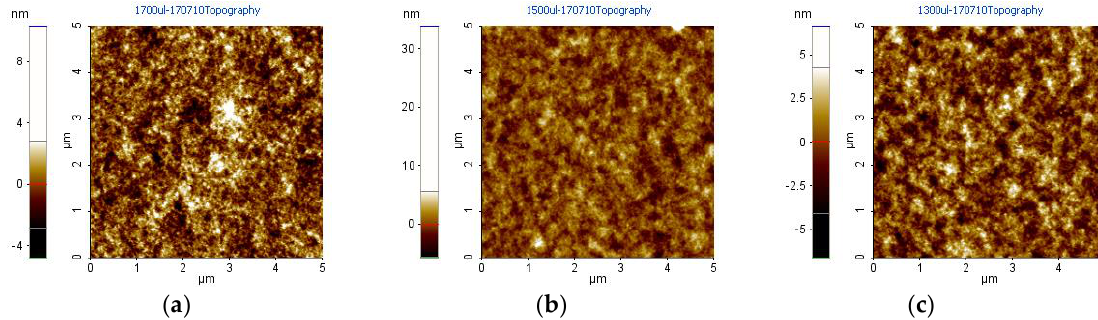
Figure 3. The surface roughness and grain size of improved PEDOT:PSS with three extractions of ( a ) 1700, ( b ) 1500, and ( c ) 1300 µ L from an atomic force microscope (AFM) measurement. Table 2. The surface roughness (Rq) values about improved PEDOT:PSS with three extractions of 1700, 1500, and 1300 µ L, which were coated on the glass substrate. Extraction of PEDOT:PSS Solution (μL) Rq (nm) 1700 1.190